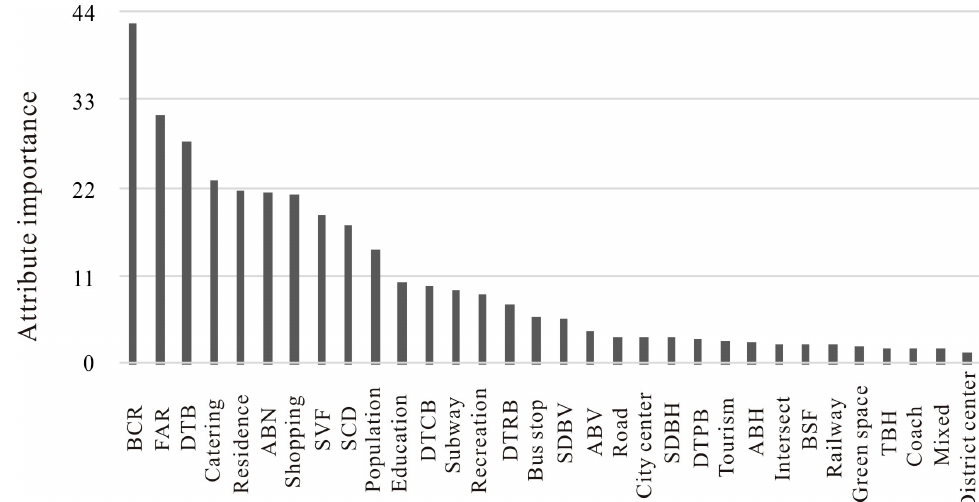
Figure 7. Permutation importance of every potential driver to urban vitality (new model).